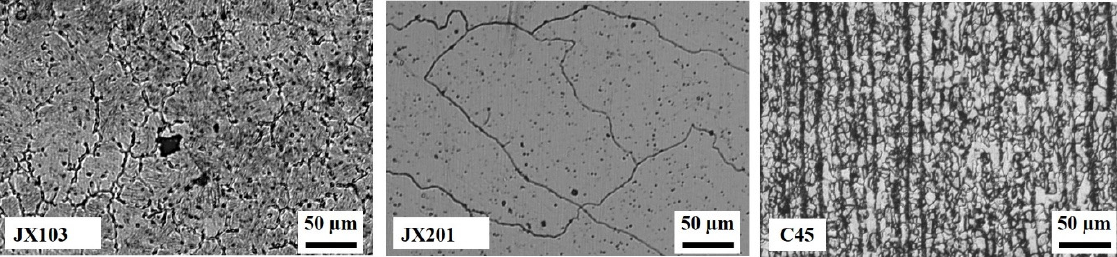
Figure 5. Microstructures of JX103 (Fe-based), JX201 (Ni-based), and C45 (base material).